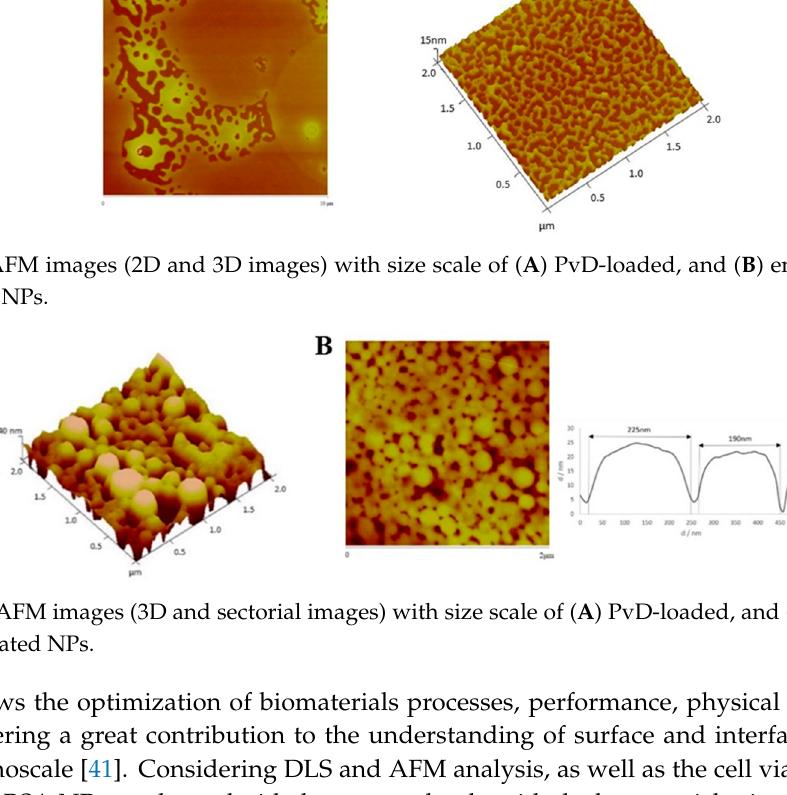
Figure 8. AFM images (3D and 2D images) with size scale of A) PvD-loaded, and B) empty ERL conjugated NPs.